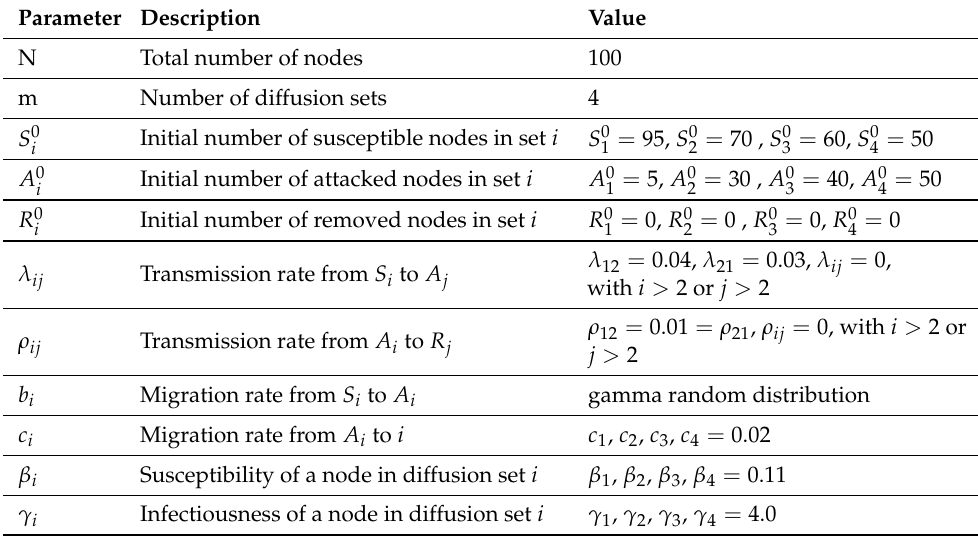
Table 2. Diffusion model’s